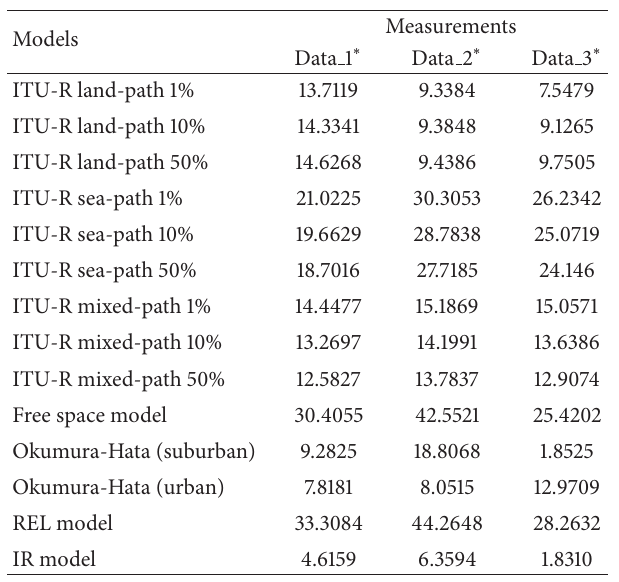
Table 2: The RMSE model selection results.